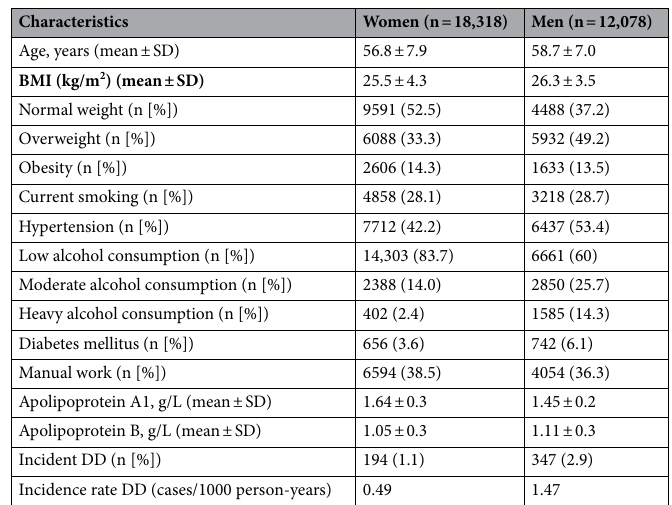
Table 1. Baseline characteristics stratified for sex. Normal weight; BMI < 25, overweight; BMI ≥ 25 to < 30, obese BMI ≥ 30 kg/m 2 . Low alcohol consumption < 15 g /day, Moderate alcohol consumption 15–30 g/day, Heavy alcohol consumption > 30 g/day. Participants with prevalent DD at baseline (n = 50) were excluded. DD Dupuytren’s disease, g grams, SD standard